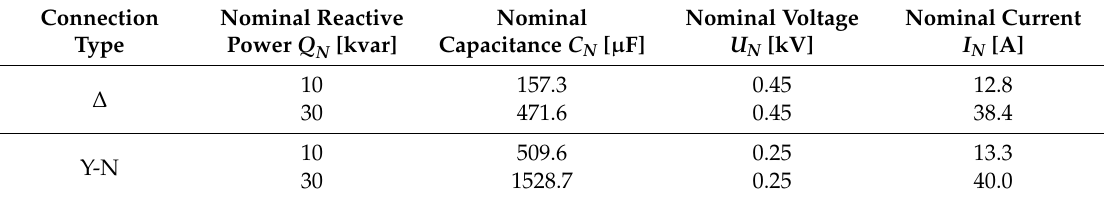
Figure 7. Experimental system setup. Table 2. Electric parameters of the tested MFCs.